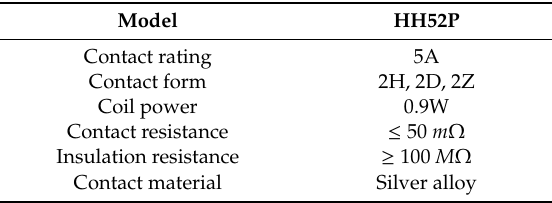
Table 1. HH52P type relay parameters.